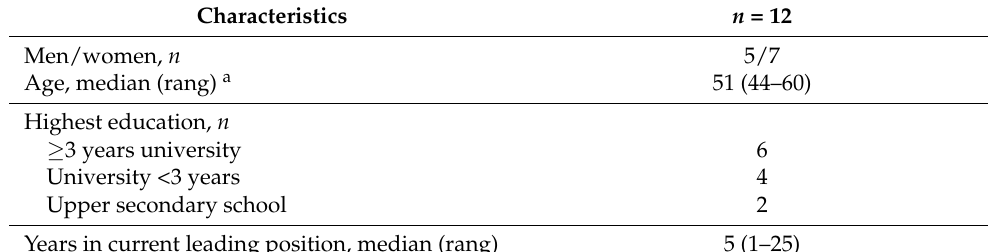
Table 1. Characteristics of the sample.